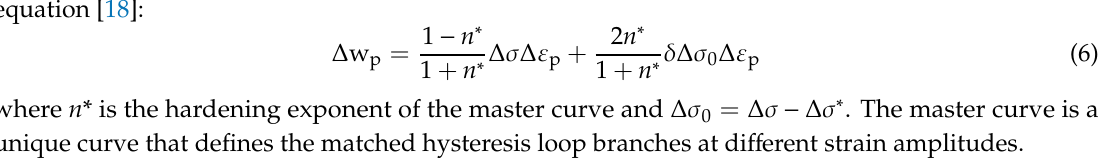
Table 6. Energy-based properties of the novel steel and 30SiMn2MoV steel. (cid:48) β Material w f Novel Steel 370.06 − 0.692 30SiMn2MoV 265.33